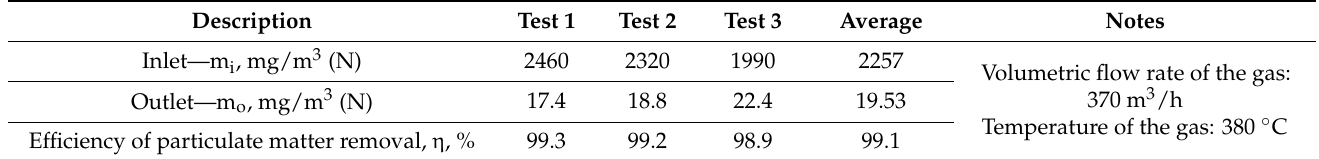
Table 1. Results of the measurements of the particulate matter content in the gas at the inlet and at the outlet of filter. Description